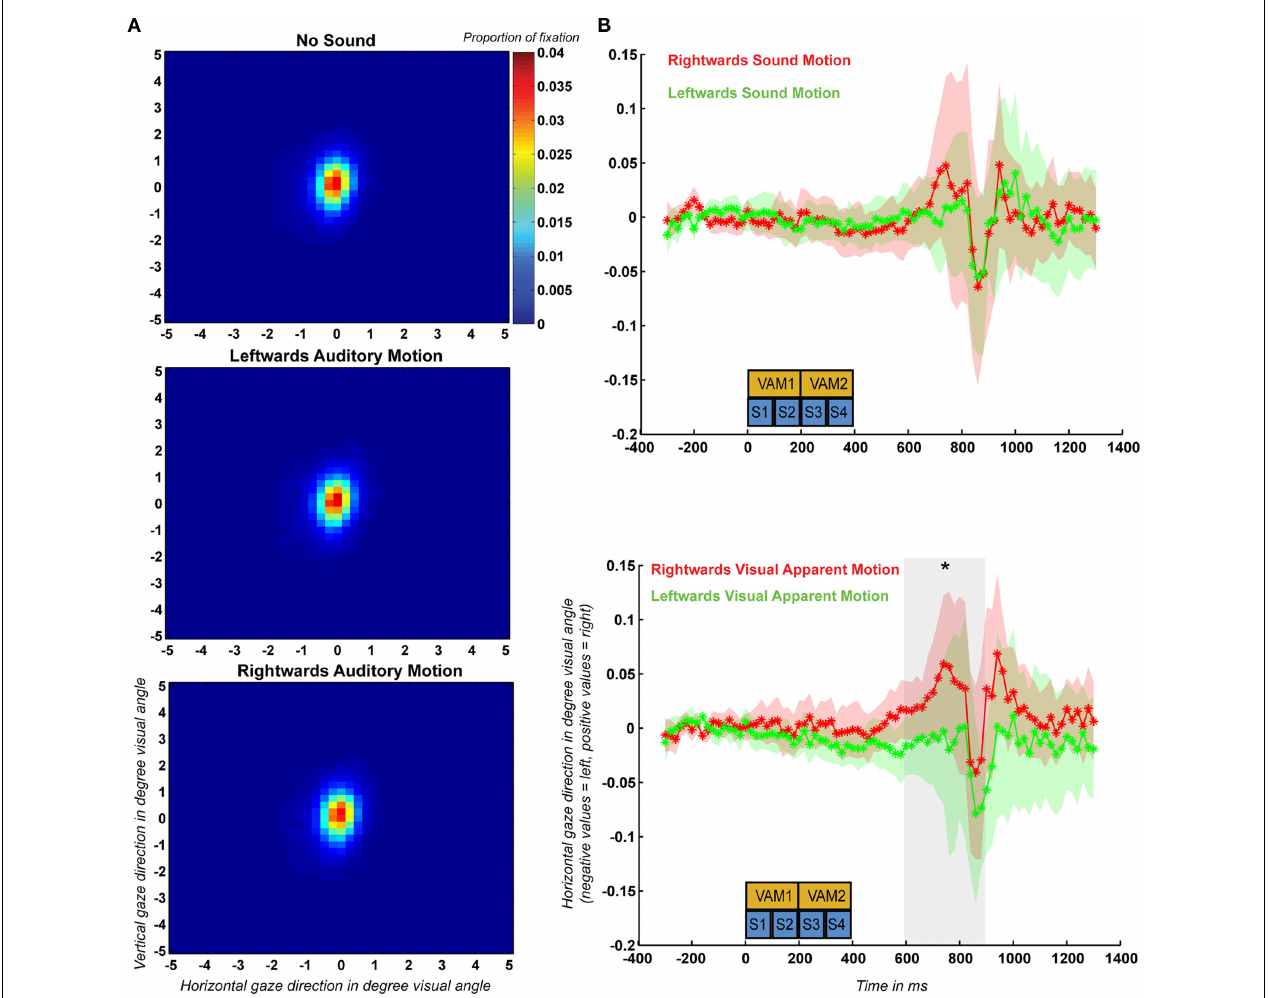
ERHEMs computed for trials during which participants perceived left and rightward visual apparent motion ( lower graph ).The blue boxes (S1–S4) indicate the time at which the four sounds were presented during a trial and the yellow boxes (VAM1–VAM2) indicate the timing of the first and second visual apparent motion stimuli.The gray transparent box in the upper part indicates the time period (600–900ms) during which there was a significant effect of visual apparent motion